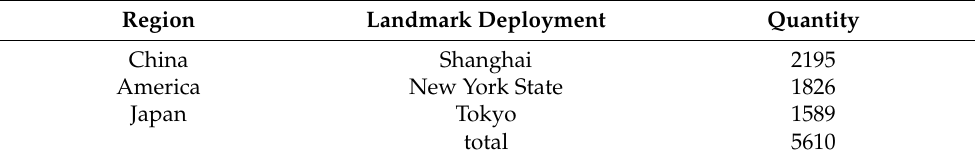
Table 2. Dataset details.